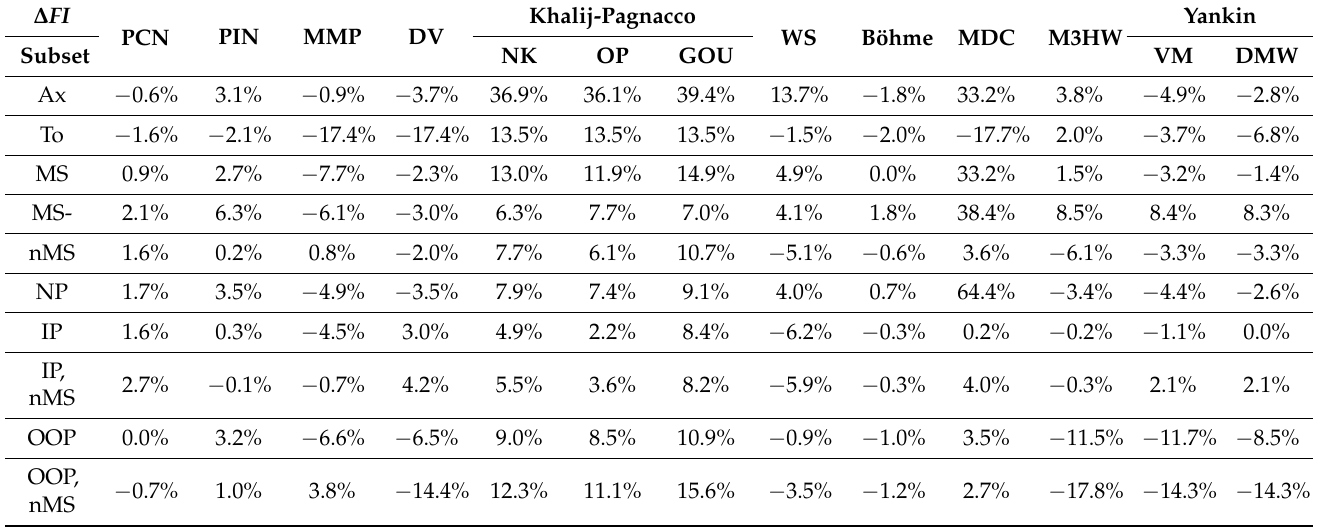
Table 11. Summary of the ∆ FI averages obtained for individual criteria and for various subgroups of FatLim.